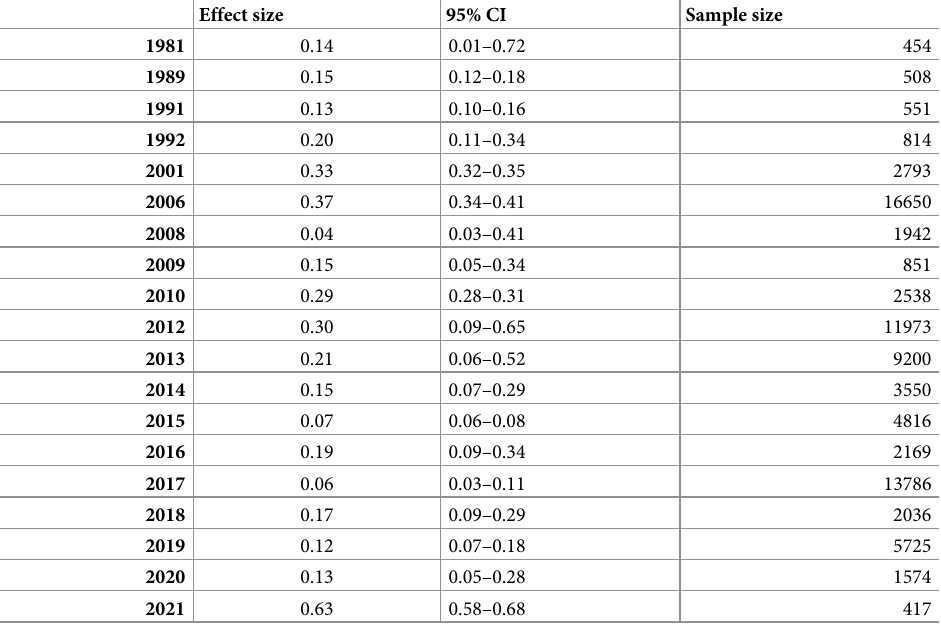
Table 2. Effect sizes of early retirement by